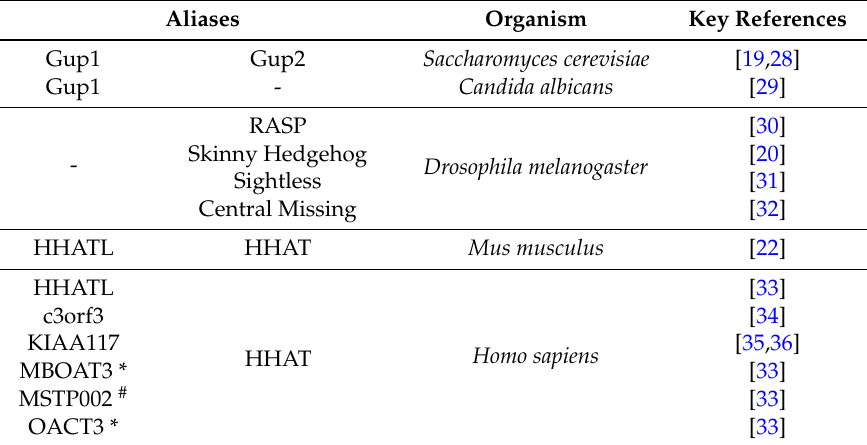
Table 1. Gup1 and Gup2 aliases in the literature and